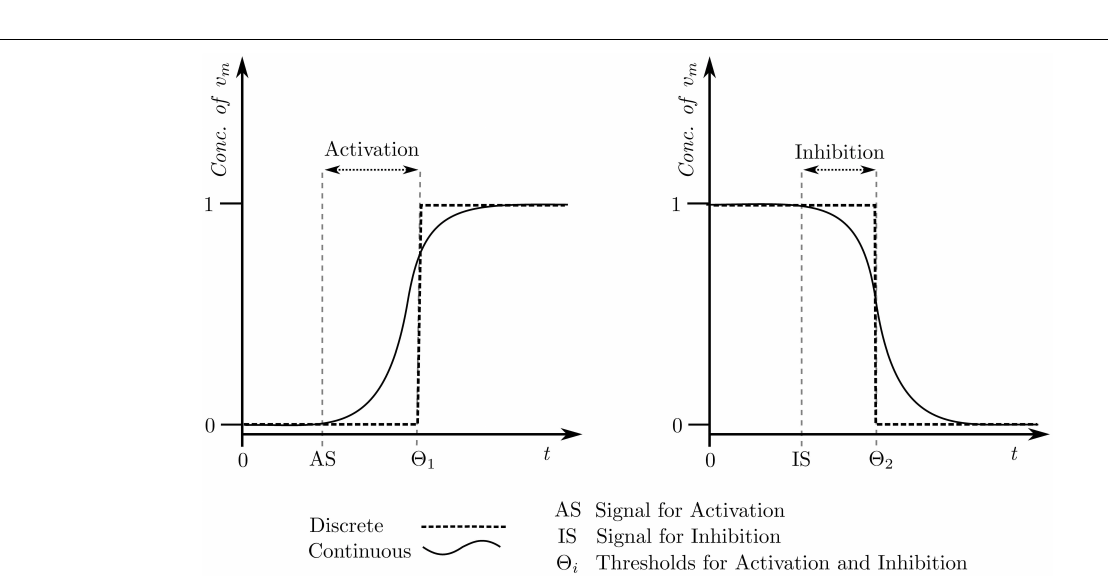
Frontiers in Environmental Science |